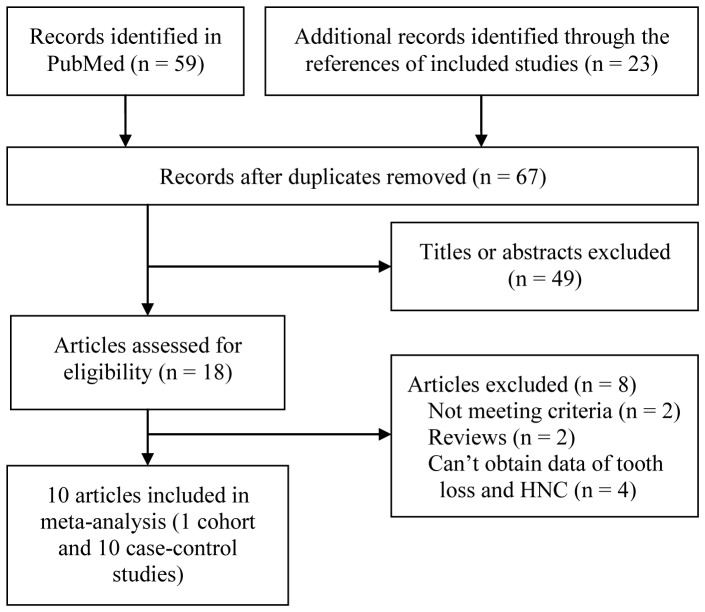
Flow chart from identification of eligible studies to final inclusion.HNC, head and neck cancer.